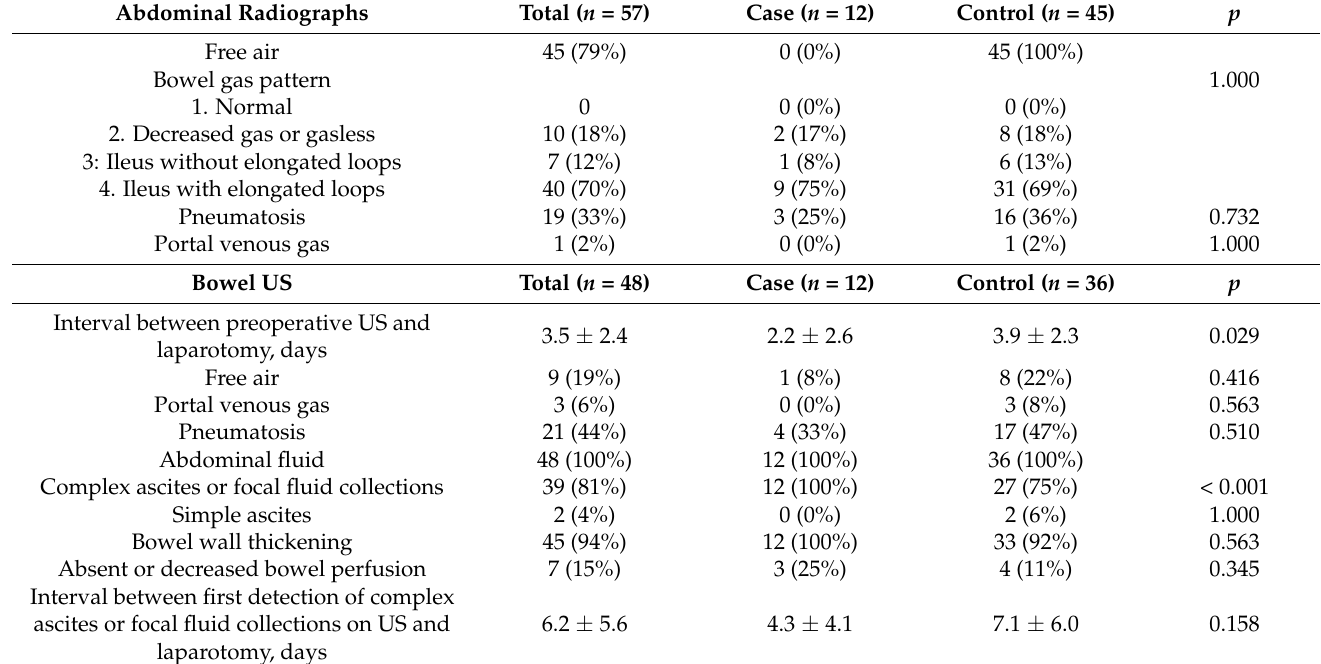
Table 2. Comparisons of imaging findings between the two